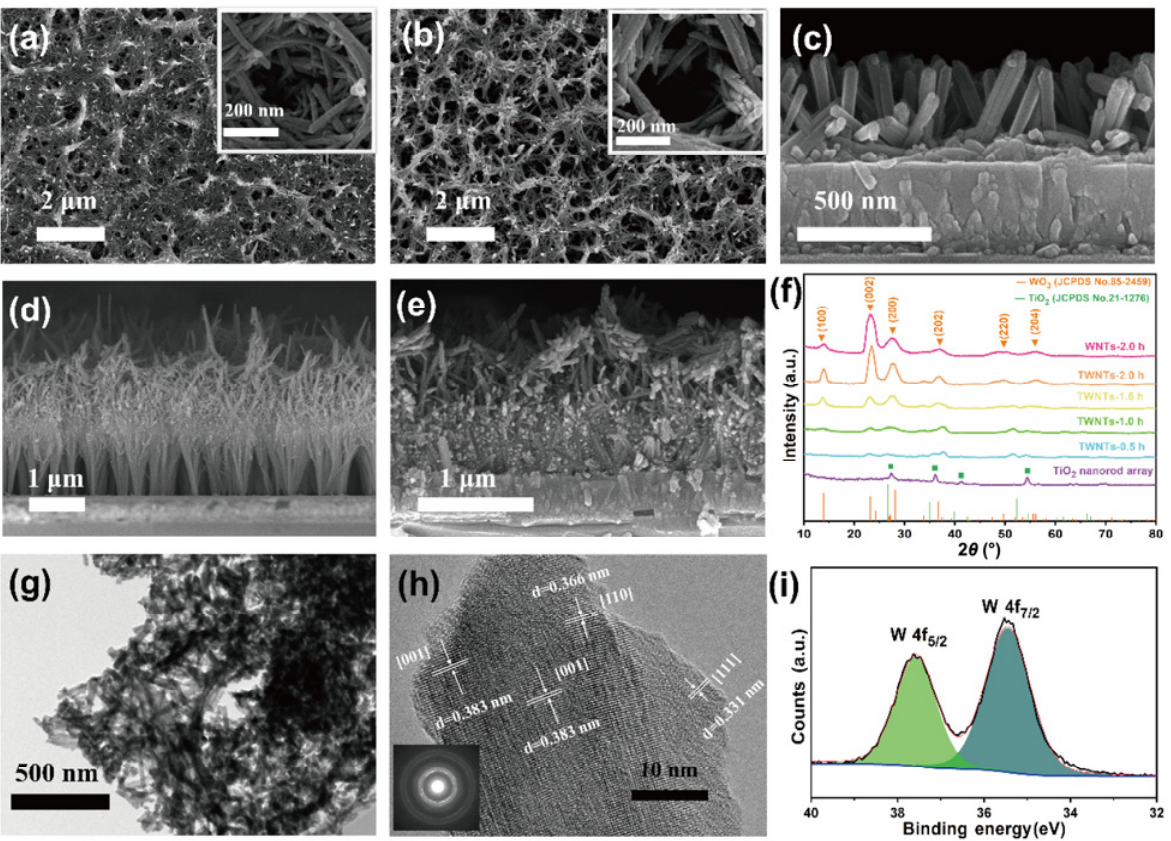
Fig. 2 Surface morphologies of WNTs film (a) and TWNTs film (b). Insets represent the high-magnification images. Cross-sectional images of TiO 2 NRAs (c), WNTs film (d), and TWNTs film (e). XRD patterns of TWNTs film with different hydrothermal time (f). TEM (g) and HRTEM (h) images of TWNTs film. The inset image in (h) is the SAED pattern. High-resolution XPS survey spectra of W 4f peak of TWNTs film